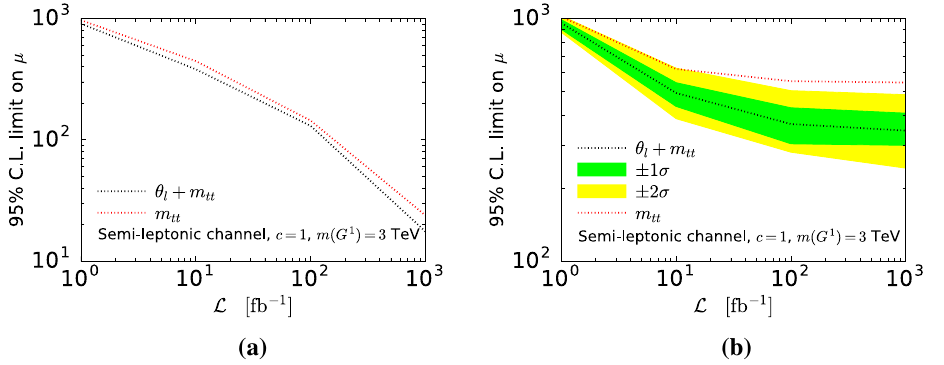
Fig. 5 Limits on μ for a narrow ( c = 1) G 1 assuming a no systemat- ics and b 5% systematics (see text for details on how this is propagated to the individual bins) which can be set with different assumed total